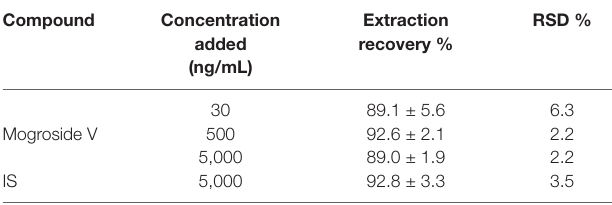
TABLE 3 | Extraction recovery of mogroside V and IS in rat plasma (n = 6). Compound